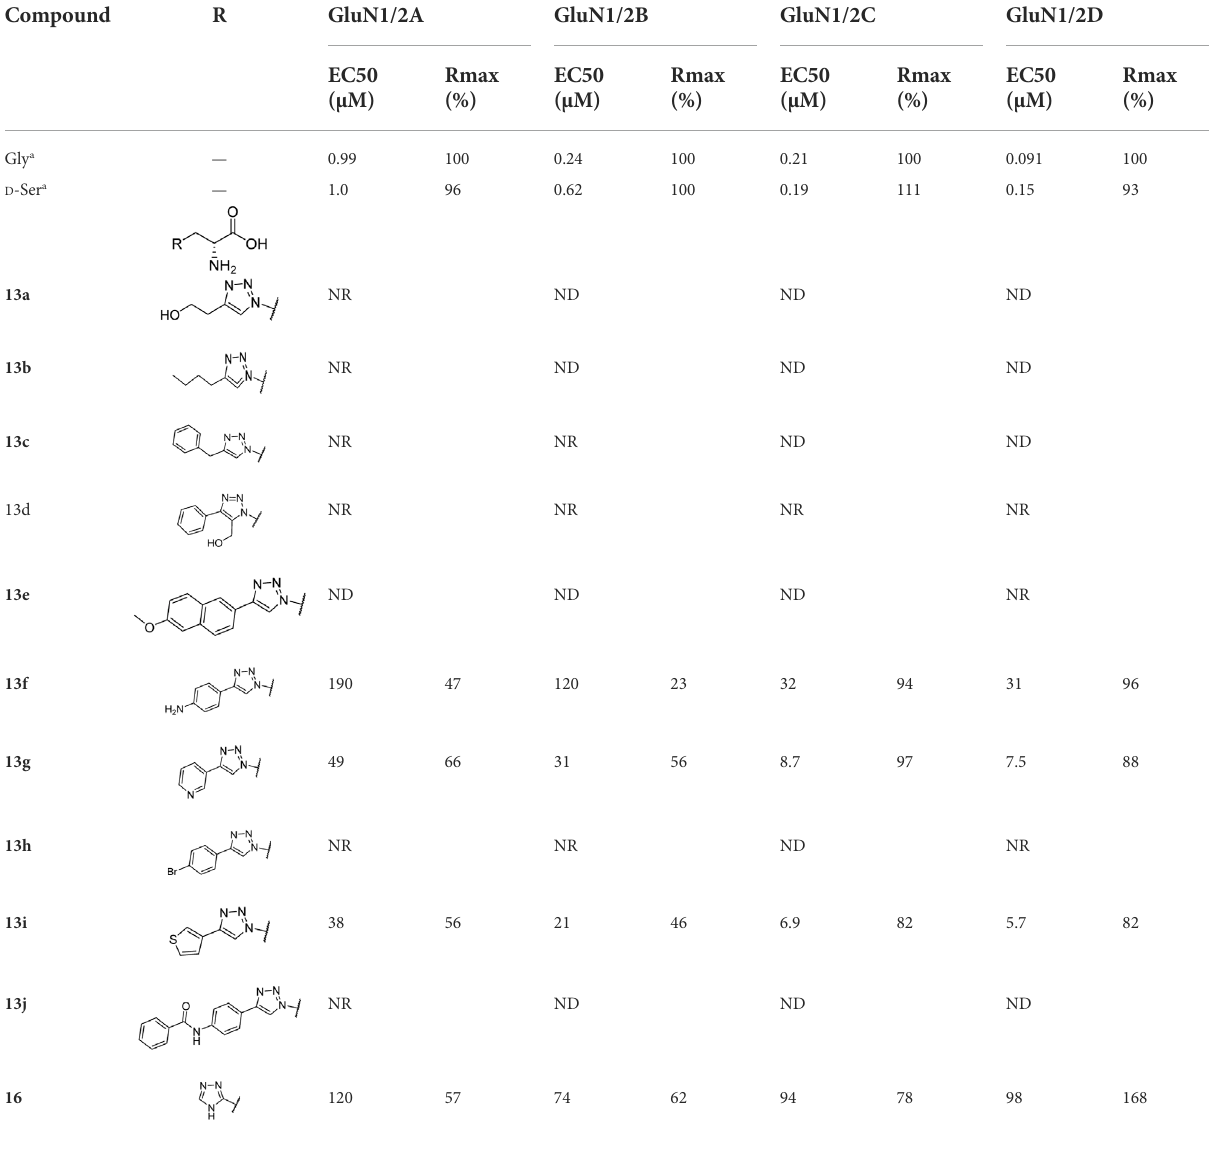
TABLE1EC 50 valuesforactivationofratNMDAreceptorsubtypesmeasuredusingtwo-electrodevoltage-clampelectrophysiologyinthepresenceof 300 µM Glu. Relative ef fi cacy is the fi tted maximal response to the agonist compared to maximal response to 100 µM Gly in the same recording. ND means that the EC 50 could not be determined, but some agonist activity was observed. NR indicates less than 5% response at 100 µM of the agonist. Data are from 3 – 13 oocytes. a Data for Gly and D -Ser are previously published (Zhao et al., 2022). See Supplementary Table S1 in the Supporting Information for sample sizes, Hill slopes, and standard error of